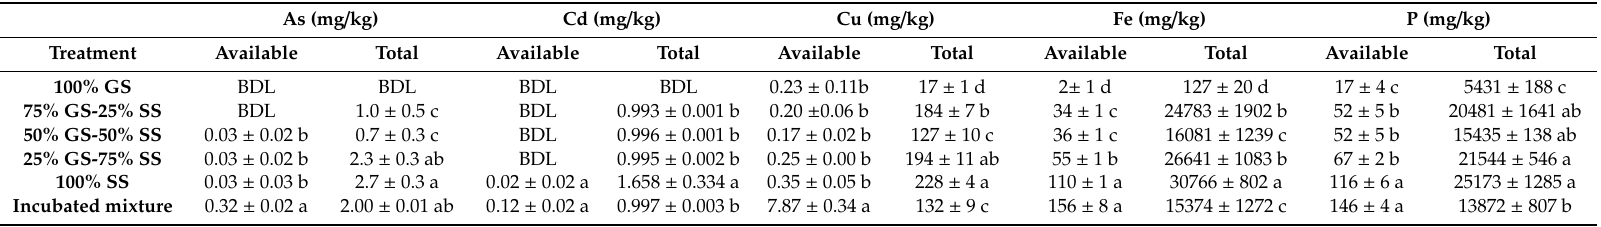
Letters are comparing the treatments in each row. BDL: below the detection